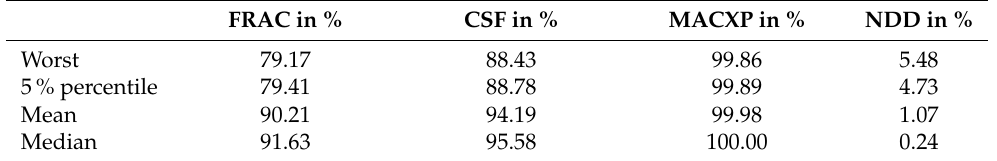
Table 3. Statistics of model performance indicators using the identified stiffness and damping parameters for the case “model vs. ideal model” for the validation position z 1